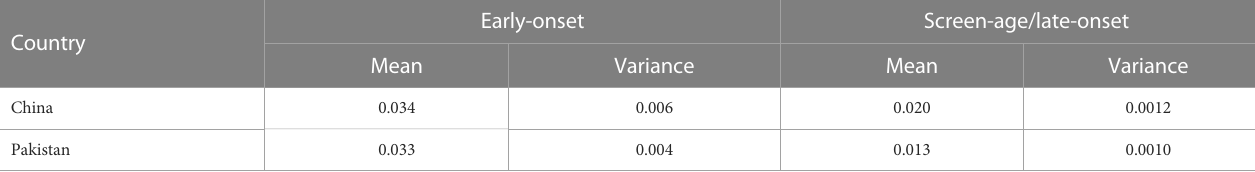
TABLE 2 Mean and variance of forecast error in life expectancy derived from the Lee – Carter model.